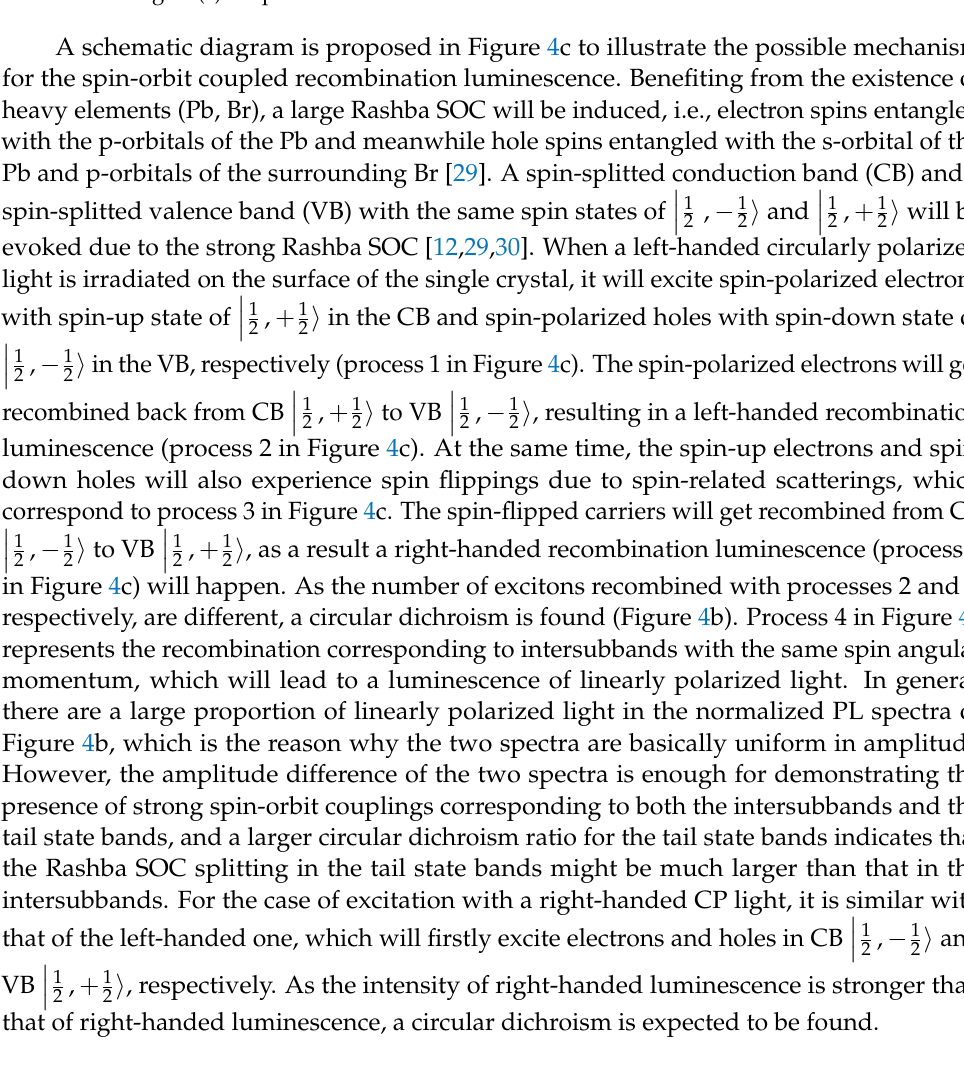
Figure 4. ( a ) Schematic optical path configuration for the measurement of circular dichroism. ( b ) The normalized circularly polarized PL intensity and the circular dichroism ratio as a function of luminescence wavelength when a left-handed polarized light is applied as an excitation light. ( c ) Proposed mechanism for the circular dichroism